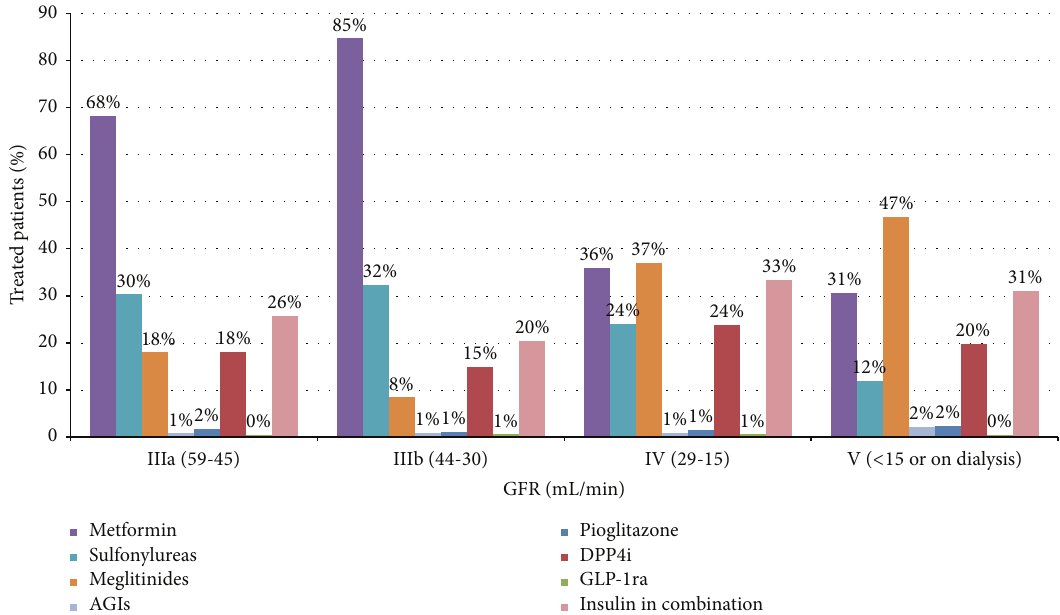
Figure 1: NIADs prescribed (alone or in combination) stratified by disease stage in patients with some degree of renal failure (GFR < 60 mL/min) (percentages are calculated for the total number of patients in each stage). AGI: alpha-glucosidase inhibitors; GLP-1ra: glucagon- like peptide-1 (GLP-1) receptor agonists; GFR: glomerular filtration rate; DPP4i: dipeptidyl peptidase-4 (DPP-4) inhibitors; NIAD: noninsulin antidiabetic